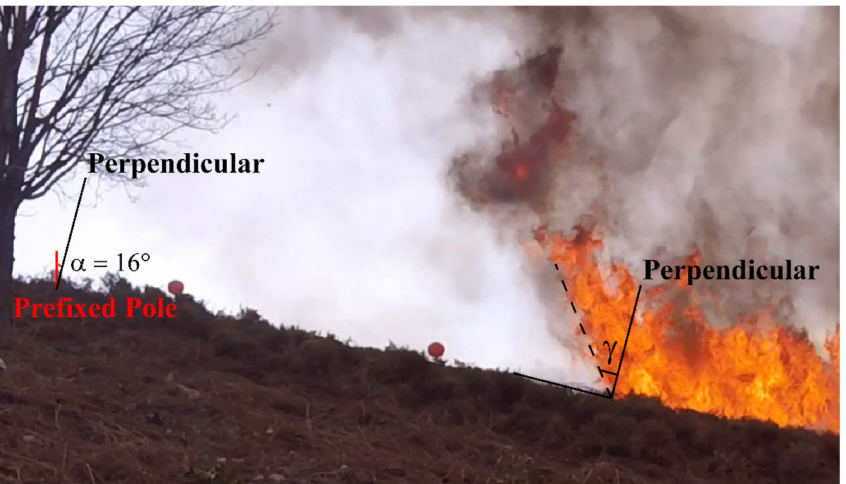
Figure 7. Visual estimation of the flame inclination angle for the experiment of March